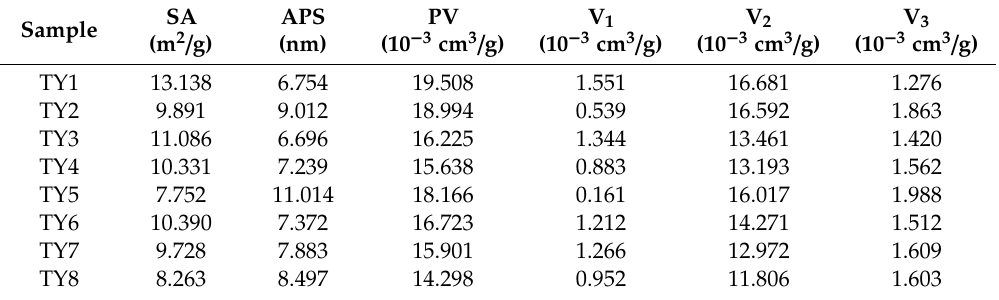
Table 3. Pore structure parameters of the shale samples from N 2 adsorption isotherms. SA: